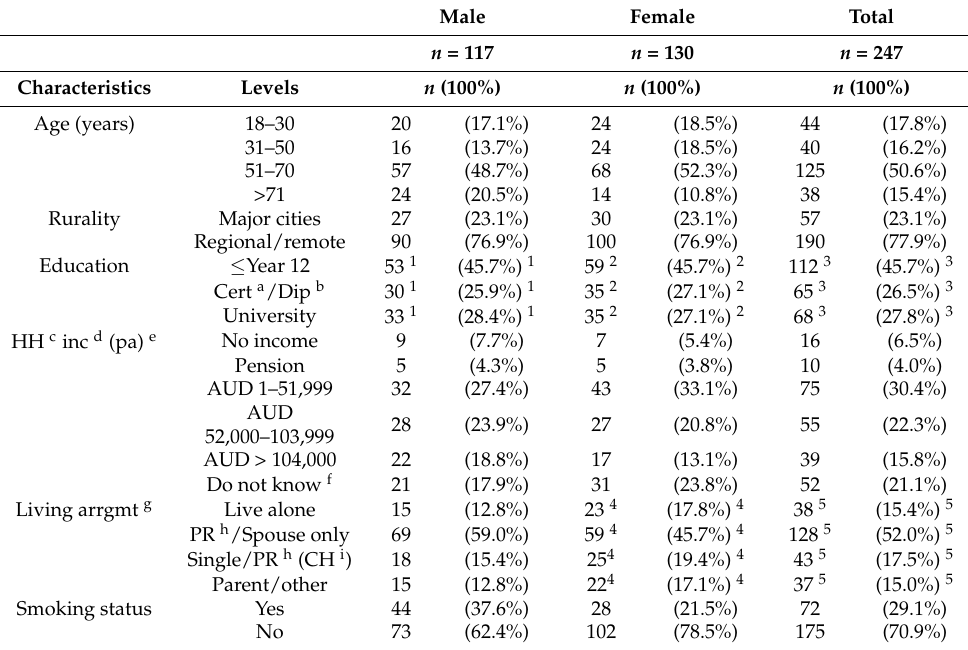
Table 1. Total number and percentage for sociodemographic characteristics in a sample of Australian